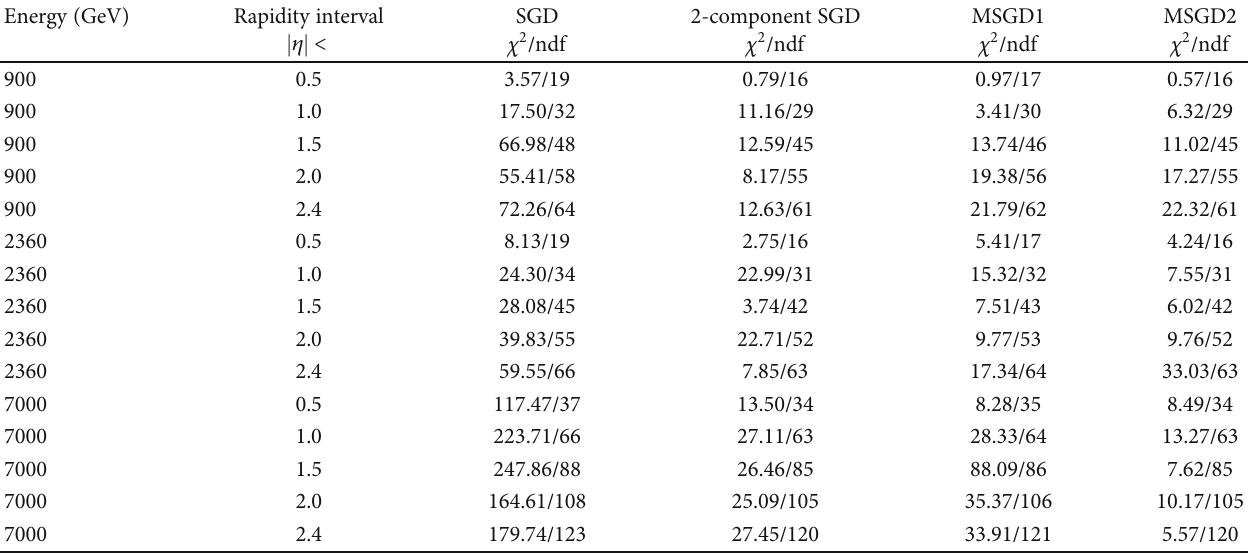
Table 1: χ 2 /ndf for charged multiplicity distribution fi tted with shifted Gompertz, 2-component shifted Gompertz, MSGD1, and MSGD2 distributions for pp